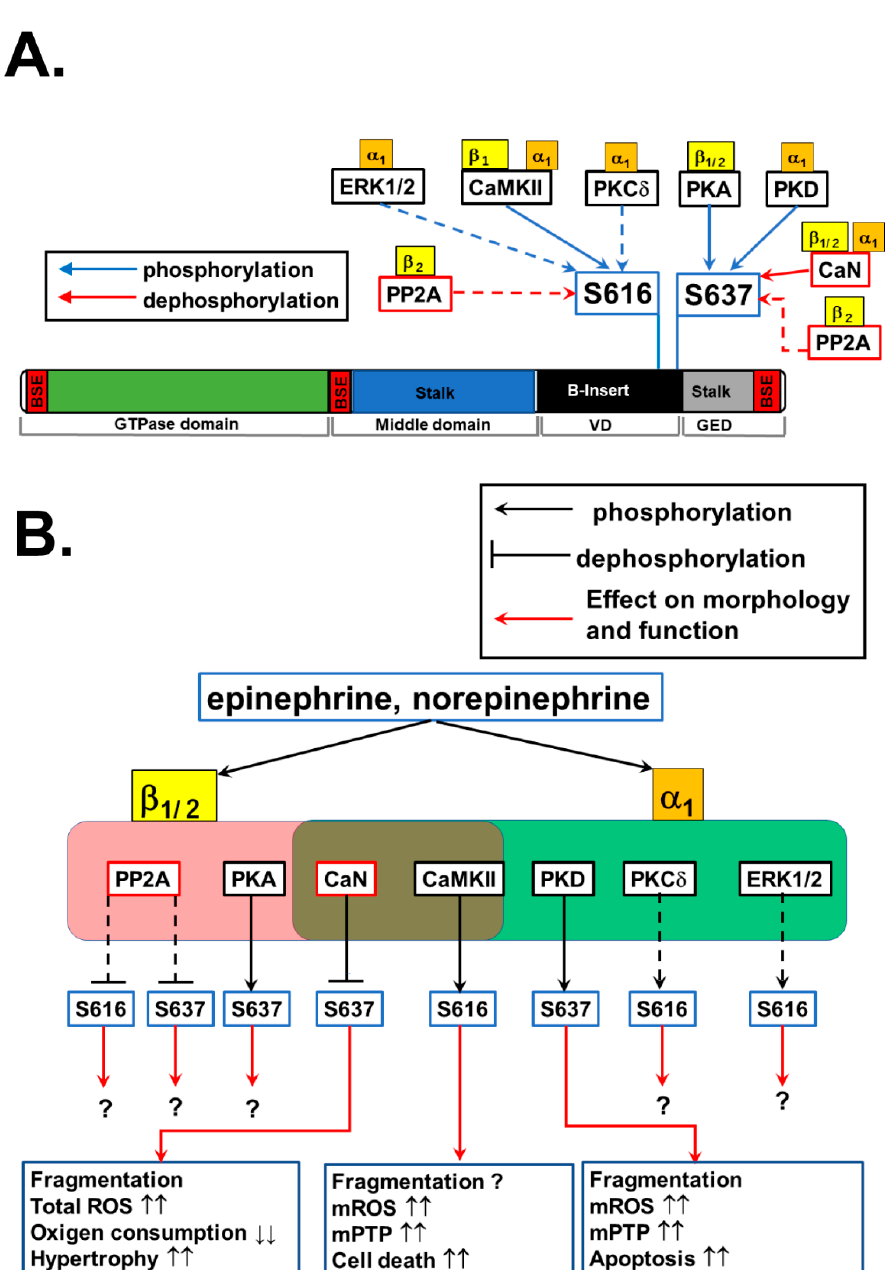
Figure 3. Phosphorylation of DLP1 and their effects on mitochondrial morphology and mitochondrial and cellular functions in cardiomyocytes: ( A ) DLP1 phosphorylation at S616 and S637 and their potential upstream signaling under AR stimulation. The upstream AR subtype(s) of each enzyme is(are) also shown. Dotted lines indicate the pathways reported in non-cardiac cells, but not yet tested in CMs. PP2A, Protein phosphatase 2; CaN, calcineurin. ( B ) Schematic diagram of DLP1 phosphorylation at S616 and S637 by AR signaling and their effects on mitochondrial morphology as well as mitochondrial and cellular functions in CMs. Dotted lines indicate the pathways reported in non-cardiac cells. If the functional effect of the signaling pathway has not yet been tested in CMs, question mark “?” is shown. The effects of CaN, CaMKII, and PKD are extracted from the following publications [56,57,60].